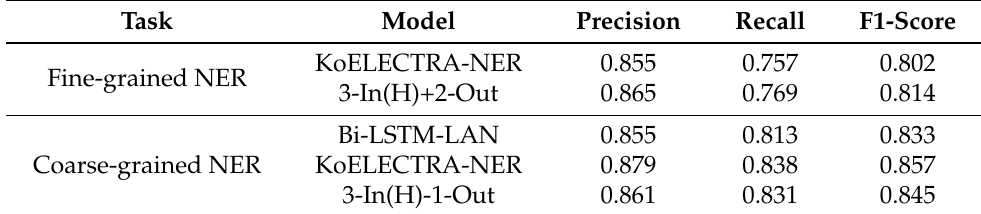
Table 6. Performance comparison with the previous